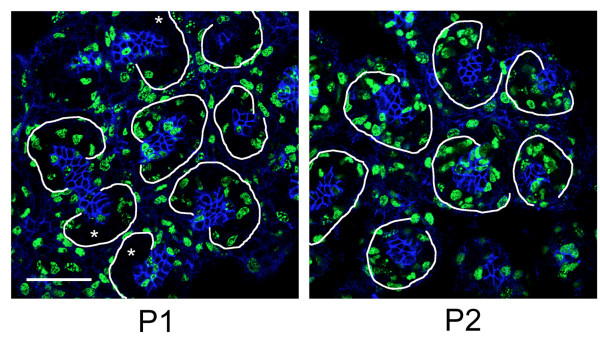
Cell cycle S-phase labeling by nucleoside analog incorporation with EdU (green) showed a higher rate of cell proliferation in the capping mesenchyme at P2 than at P1. At P2 the cap surrounding ureteric bud branch tips (blue - E-cadherin) contained many more cells which incorporated the label. The optical sections at P1 and P2 were obtained at the same level relative to the branch tip of the ureteric bud, just superficial to the central lumen in the branch tips of the ureteric bud. Bar = 50 microns.